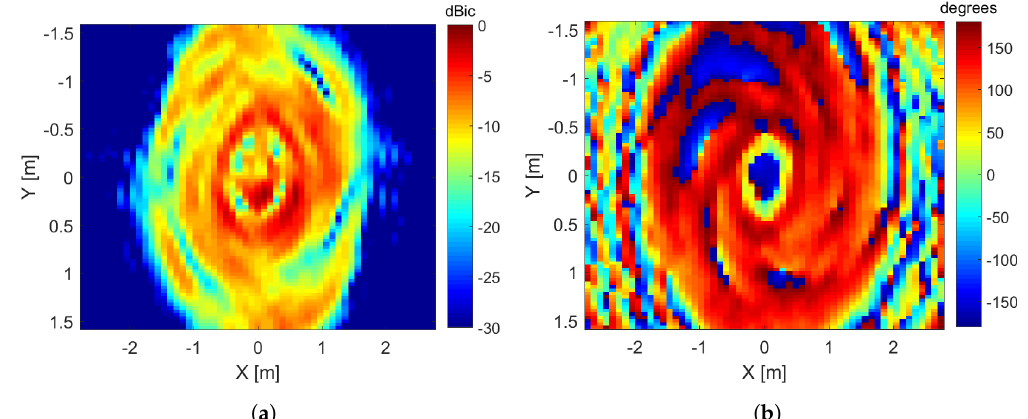
Figure 11. Hologram at aperture level in center frequency of: ( a ) field amplitude; and ( b ) phase